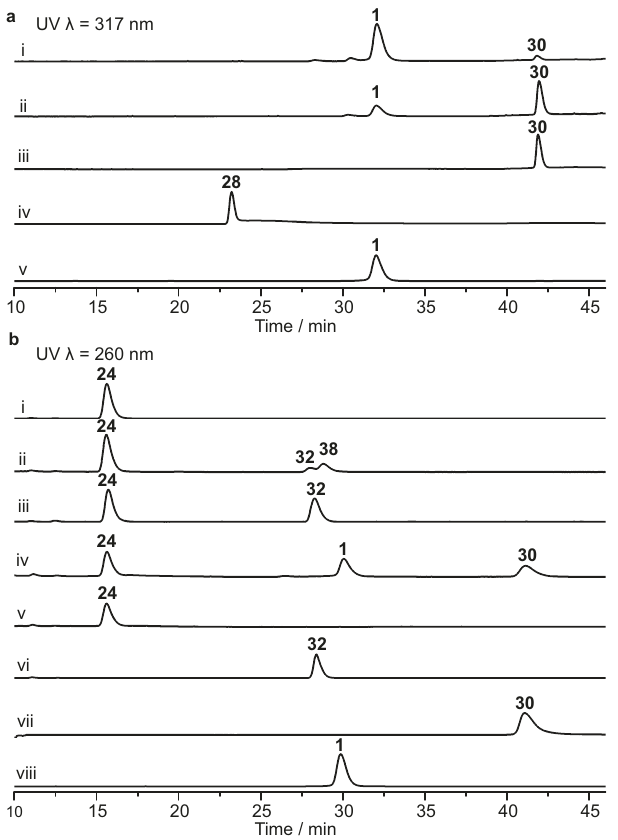
Fig.4|HPLCanalysisofthereactionscatalyzedbyKnmF,KnmB1,andKnmB2. a HPLCanalysisofKnmF-catalyzedreactionsinthepresenceof 28 ,SAMandKnmF. (i) 2h; (ii) 30min; (iii) 15min; (iv) the control reaction in the presence of 28 and SAM;(v) standard 1 . b HPLCanalysis ofKnmB1- andKnmB2-catalyzed reactions. (i) the control reactionin the presence of 24 , SAM and NADPH;(ii) the reactionin the presenceof 24 ,SAM,NADPH,KnmB2andKnmF;(iii)thereactioninthepresenceof 24 , SAM and KnmF; (iv) the reaction in the presence of 24 , SAM, NADPH, KnmF, KnmB1 and KnmB2; (v) the reaction in the presence of 24 , NADPH, KnmB1 and KnmB2; (vi) standard 32 ; (vii) standard 30 ; (viii) standard 1 . Source data are pro- vided as a Source Data fi